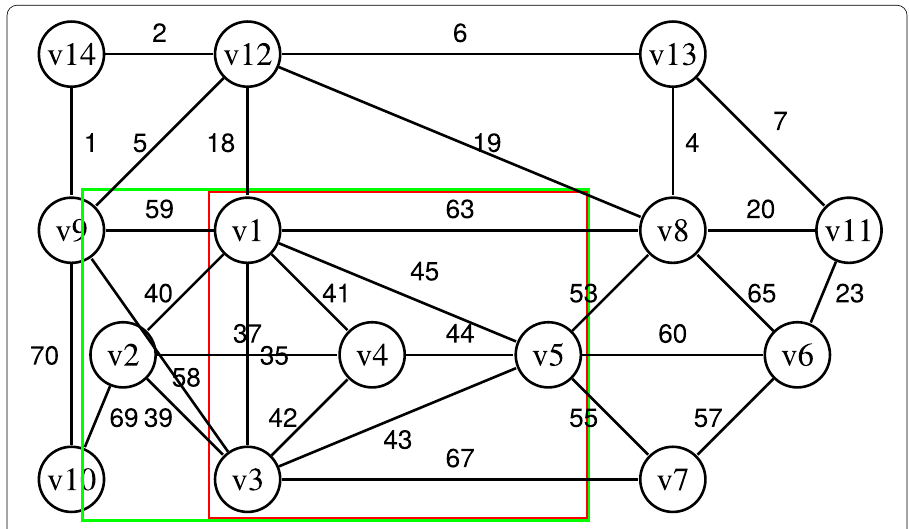
Fig. 2 Graph example and its weighted